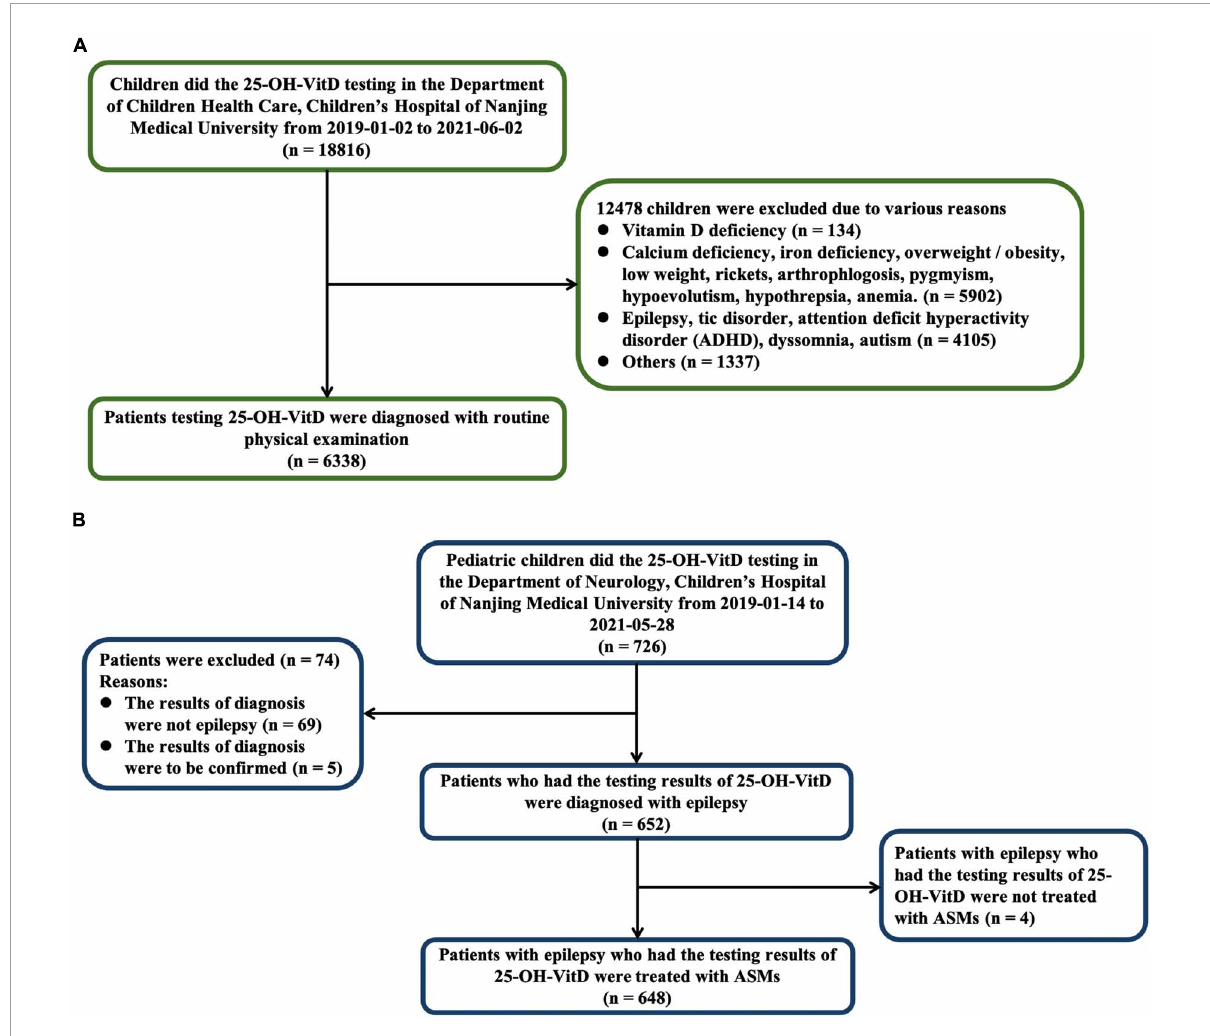
FIGURE1 Numbers of healthy children (A) and children with epilepsy (B) who were eligible for the